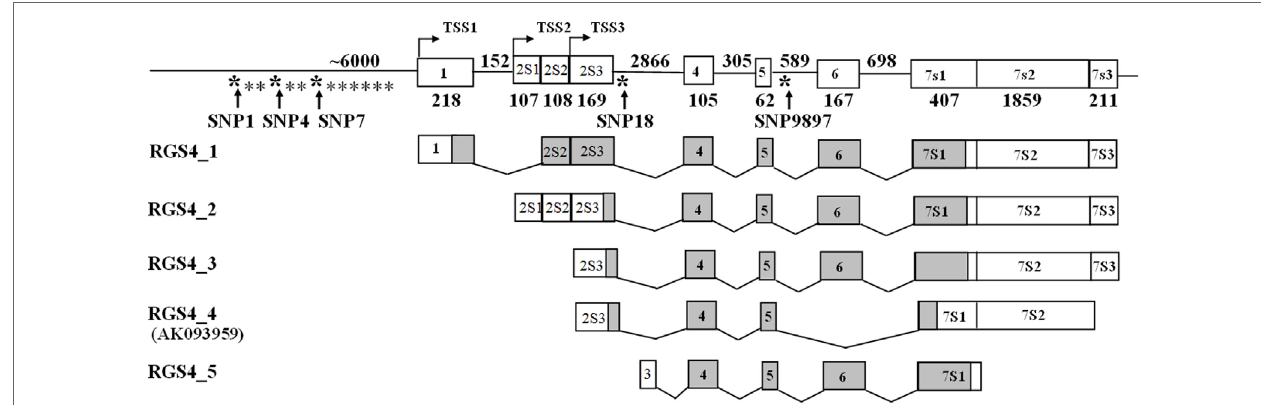
FigUre 1 | location of snPs in the RGS4 gene . SNP1, SNP4, and SNP7 are located in the 5 ′ regulatory region of RGS4 . SNP18 is in the second intron and SNP9897 is in the fourth intron of the RGS4